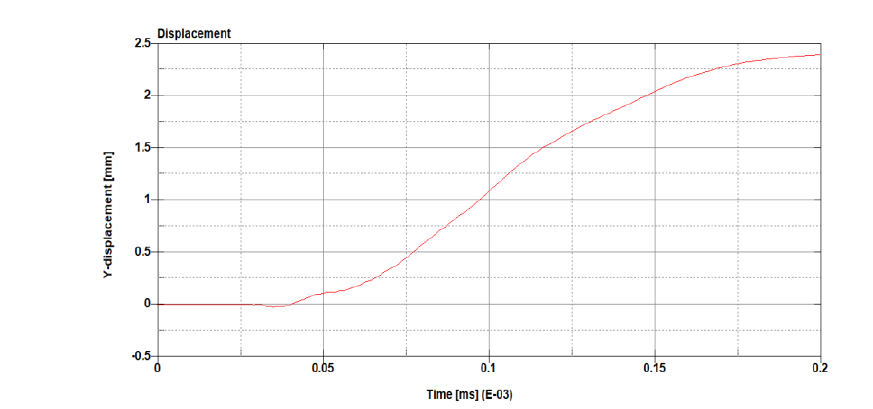
Figure 9 – Displacement of the armor plate in relation to time Рис. 9 – Смещение в зависимости от времени Слика 9 – Померање у зависности од времена